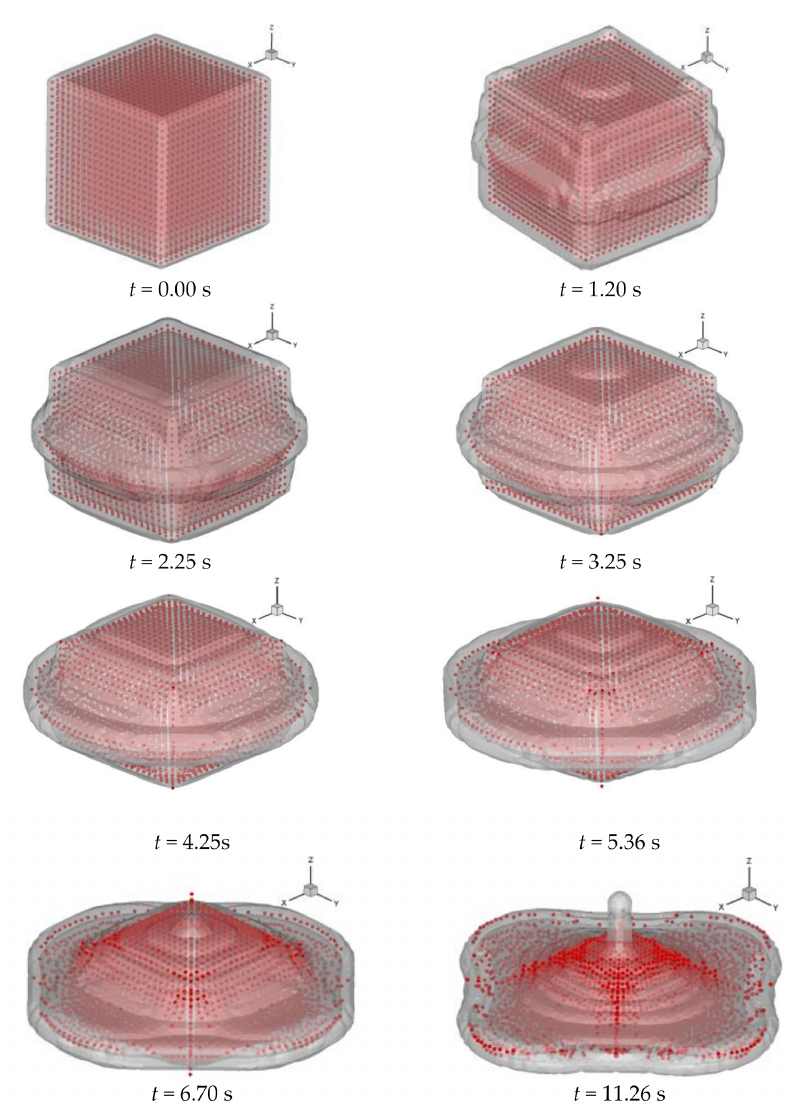
Figure 11. Deformation process comparison between Case 4 of the MPS method (red points) and the VOF (grey